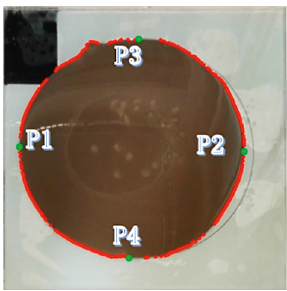
Figure 7: The boundary and extremum of cement paste.